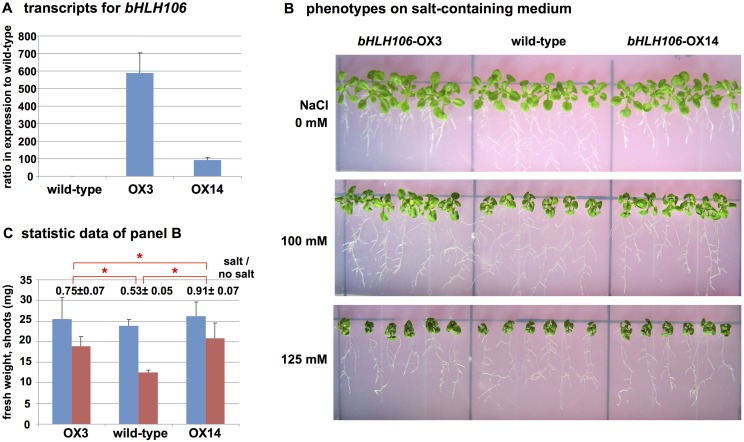
Phenotypes of OX lines of bHLH106.(A) Expression of bHLH106 in OX lines. bHLH106 was driven by the CaVM 35S promoter and F2 homozygous lines used for analysis. Total RNA was extracted from whole plants grown on standard MS. Expression was determined by real-time RT-PCR and normalized using ACTIN2 (ACT2). Error bars represent ±SEM from three experimental replicates. (B) Phenotypes of bHLH106-OX grown on culture medium containing different concentrations of NaCl. The culture and treatment of plants with NaCl was as described in the legend for Fig 3. (C) Statistic data of shoot weight of plants growth with (red column) or without (blue column) 100 mM NaCl in the same experiments shown in panel B. Error bars represent ±SEM from six experimental replicates. The numbers above columns are ratios of fresh weight of each line with salt to that without salt. Here is * for P < 0.05 in ANOVA.